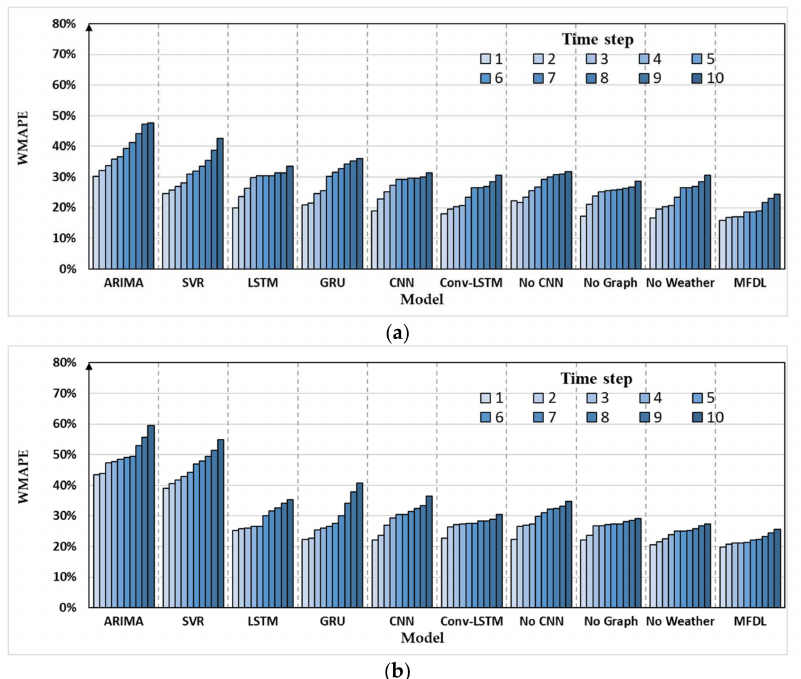
Figure 15. Comparison of different methods in terms of various time steps. ( a ) the speed ( b ) the passing